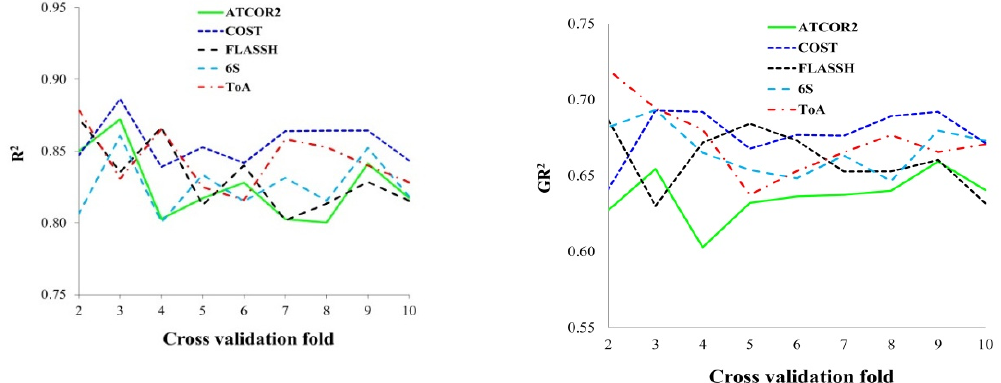
Figure 7. Variations in the goodness of fit statistics obtained by applying the cross-validation technique ( nfolds = 2–10) to the MARS models.